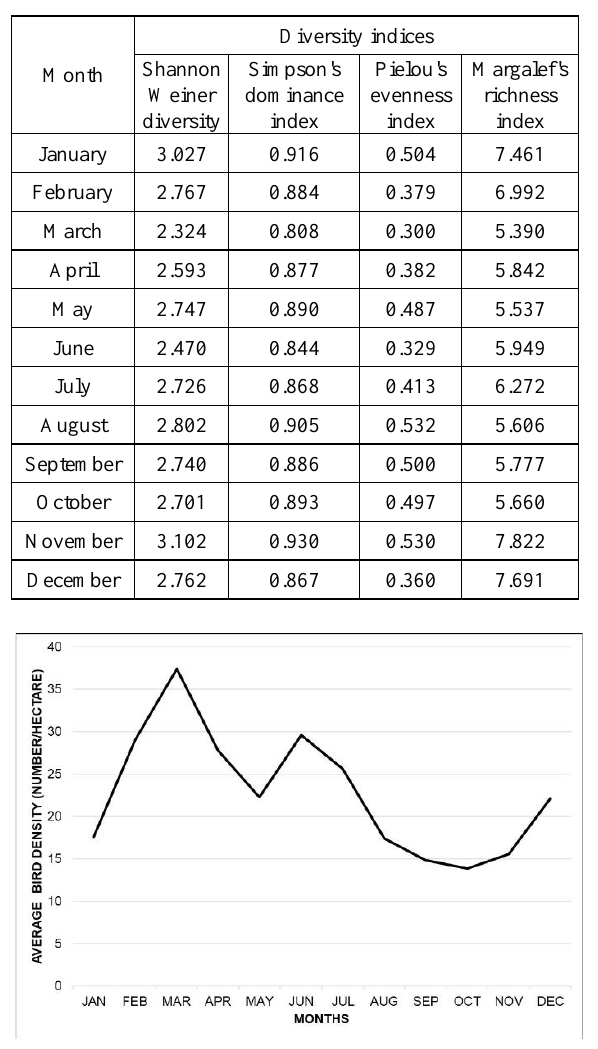
Figure 4. Average density of bird species during the year